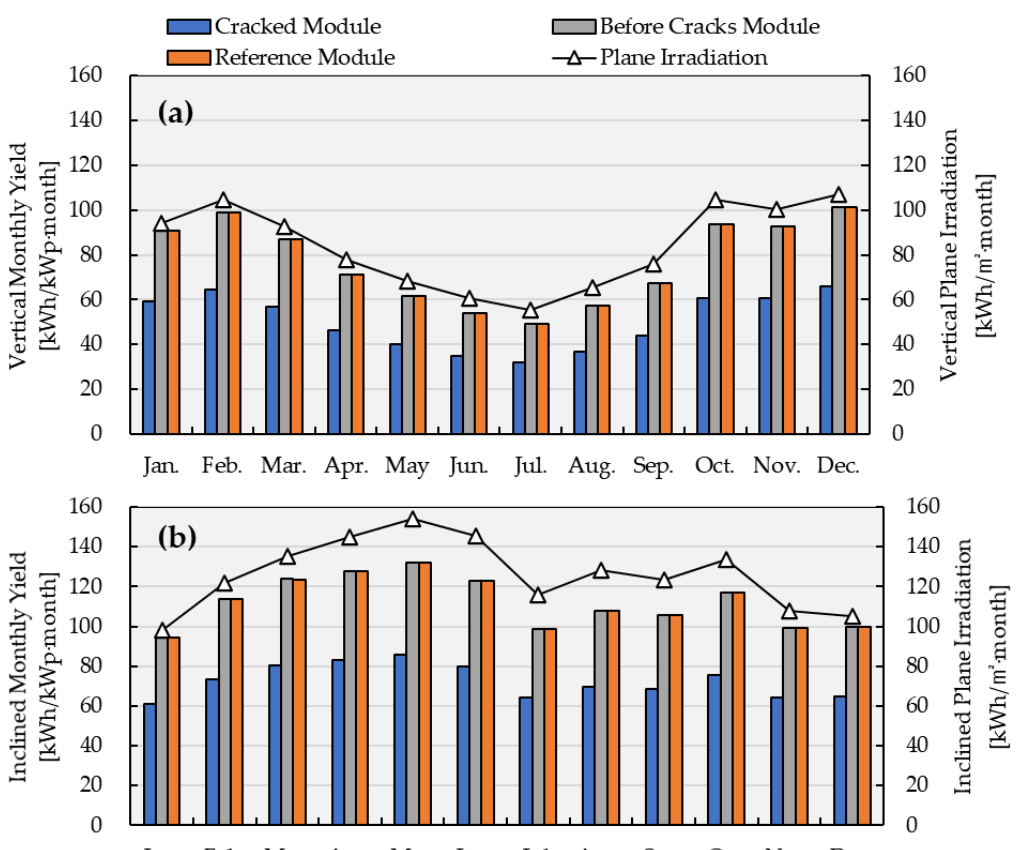
Figure 13. Comparison of monthly module yields for cracked and non-cracked modules: ( a ) vertical and ( b ) inclined plane positions.